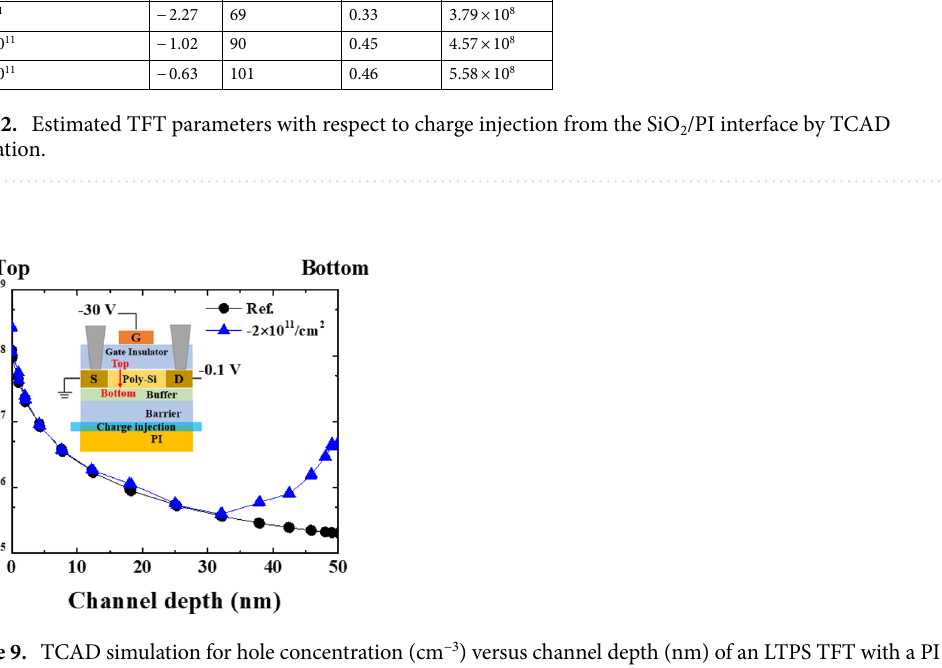
Figure 9. TCAD simulation for hole concentration (cm −3 ) versus channel depth (nm) of an LTPS TFT with a PI substrate. Reference represents a LTPS TFT with a PI substrate without charge injection at the SiO 2 /PI